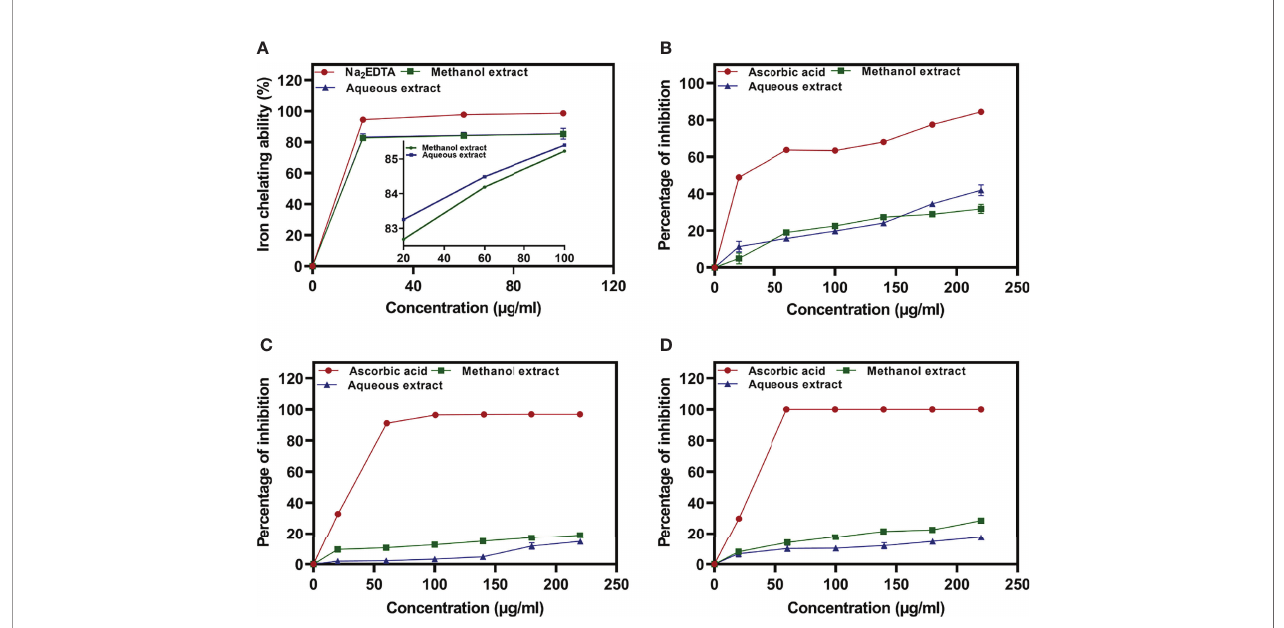
FIGURE 2 | Iron chelating activity of methanolic and aqueous extract of U. indica , along with Na 2 EDTA standard (A) , percentage inhibition of nitric oxide radicals (B) , DPPH radicals (C) , and ABTS radicals (D) via methanolic and aqueous of U. indica along with ascorbic acid